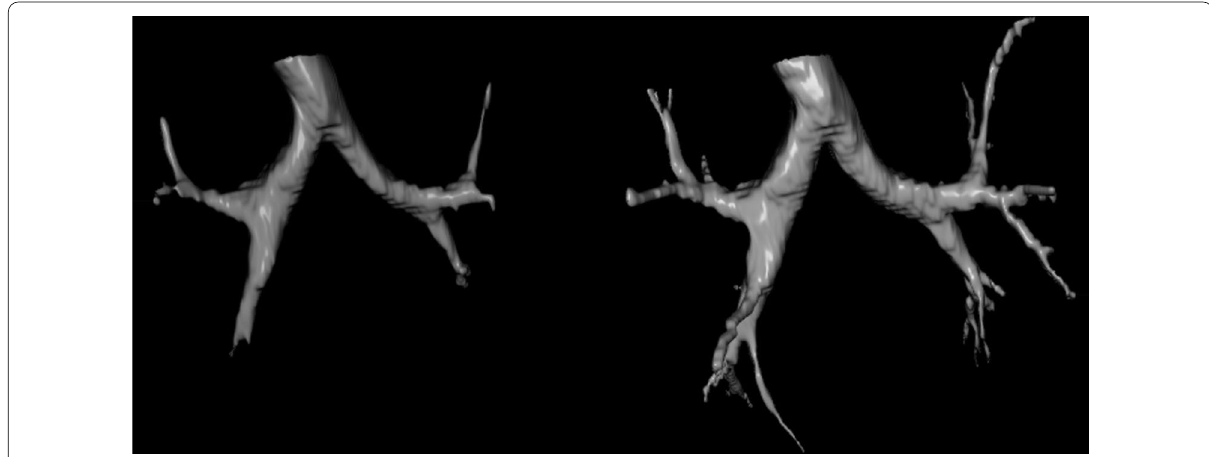
Fig. 1 Surface model of airway images segmented from ldCT (left) and hdCT (right)